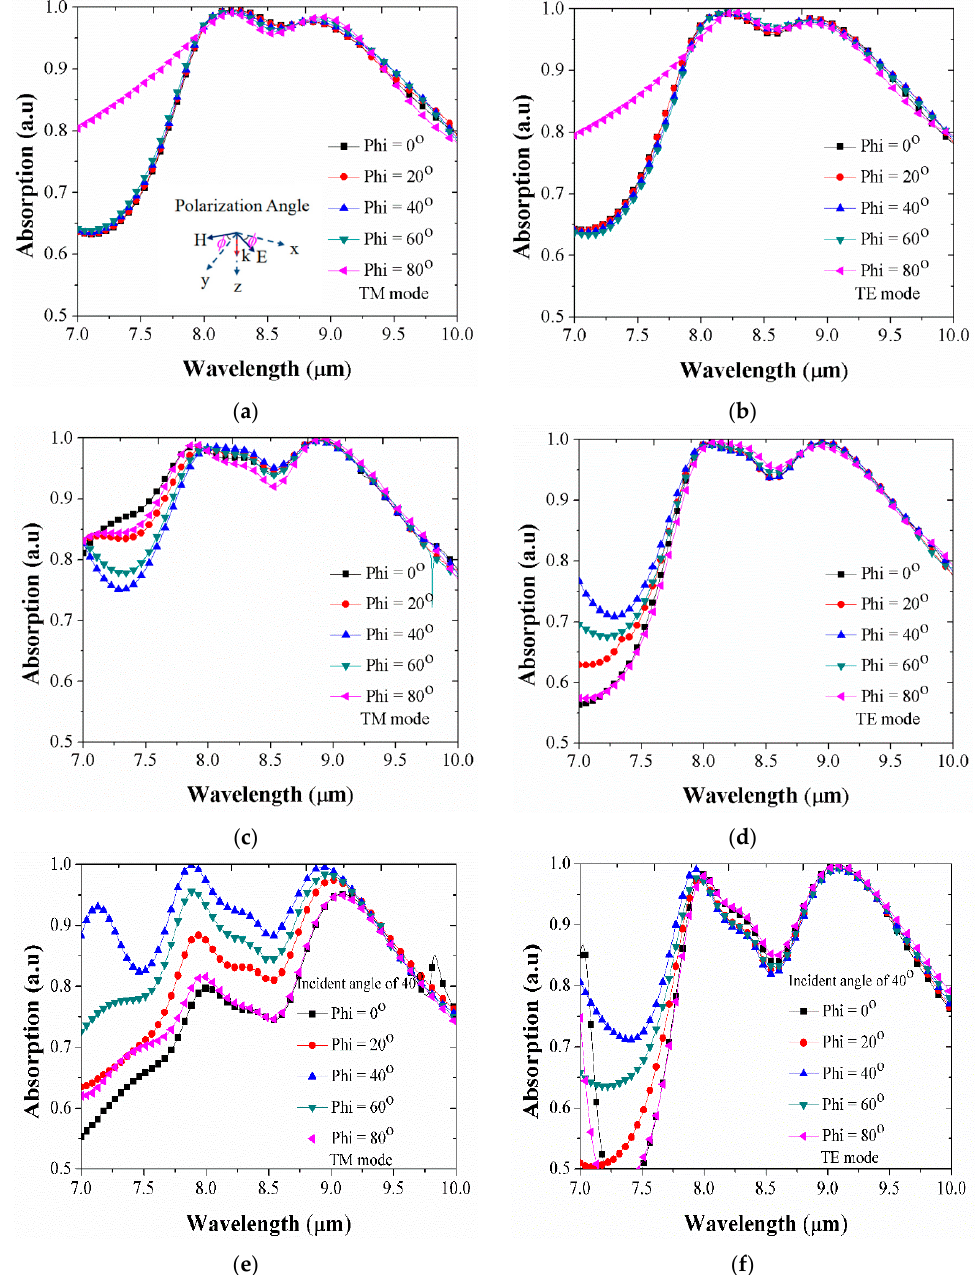
Figure 8. Absorption curves as a function of polarization angle (phi) under ( a , b ) normal incidence; ( c , d ) Brewster angle; ( e , f ) and 40° incidence . ( c , d ) Brewster angle; ( e , f ) and 40 ◦